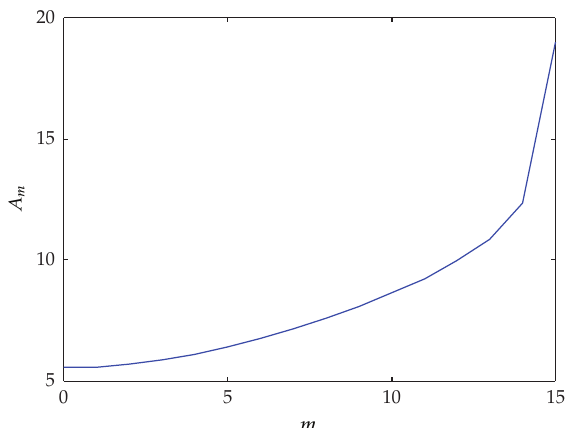
Figure 2: The dependence of the amplitude distribution for conservative system confirms reliable growth for initial